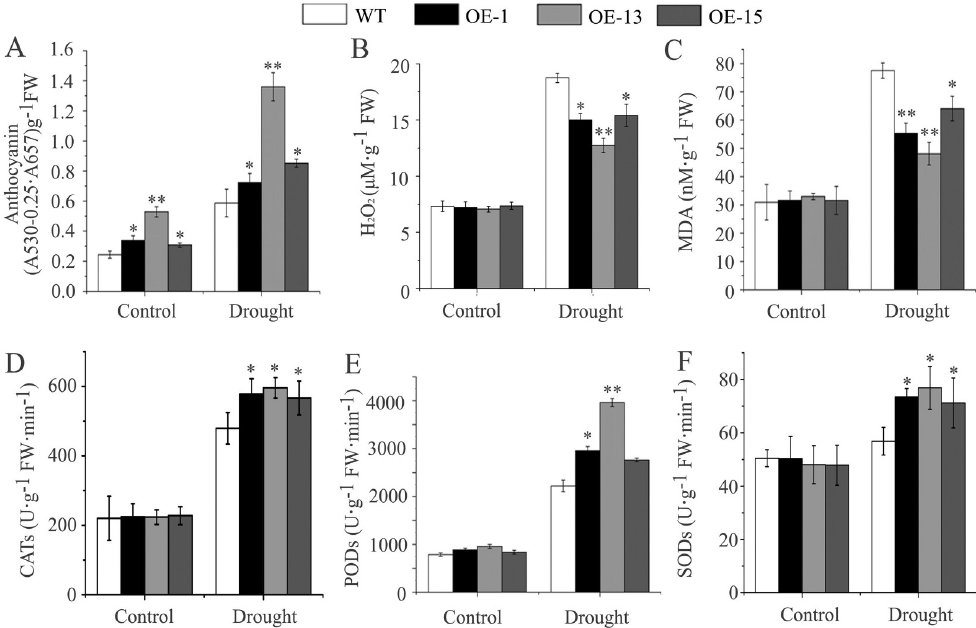
Fig 6. The changes in physiological indices in AmDREB3 transgenic Arabidopsis under drought stress. Three-week-old seedlings were suspended watering for 10 d, and the contents of anthocyanins, H 2 O 2 , and MDA as well as the activities of CAT, POD, and SOD were measured before (control) and after the drought treatment, respectively. Data are presented as means ± SDs (n = 3). Asterisks and double asterisks indicate significant differences of transgenic lines (OE-1, OE-13, and OE-15) compared to wild-type (WT) at p < 0.05 and < 0.01,